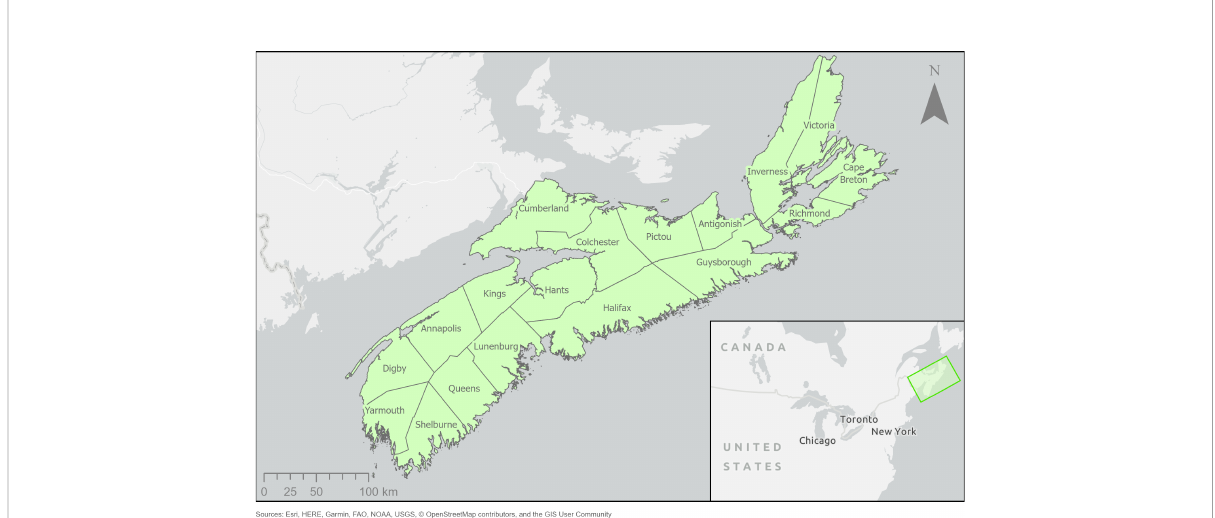
FIGURE 2 Map of Nova Scotia, the province in eastern Canada (located within the traditional and unceded territory of the Mi ’ kmaq and Wolastoqey) which compromised the geographic scope of recruitment for a research study on recreational mackerel fi shing in the region. Solid lines delineate county borders within the province (Nova Scotia Geographic Data Directory,